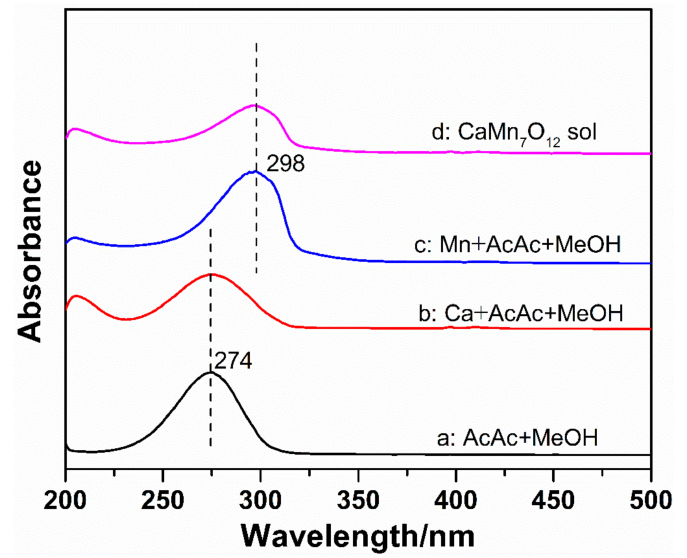
Figure 2. Ultraviolet-visible spectrometer (UV-Vis) spectra of CaMn 7 O 12 gel in di ff erent